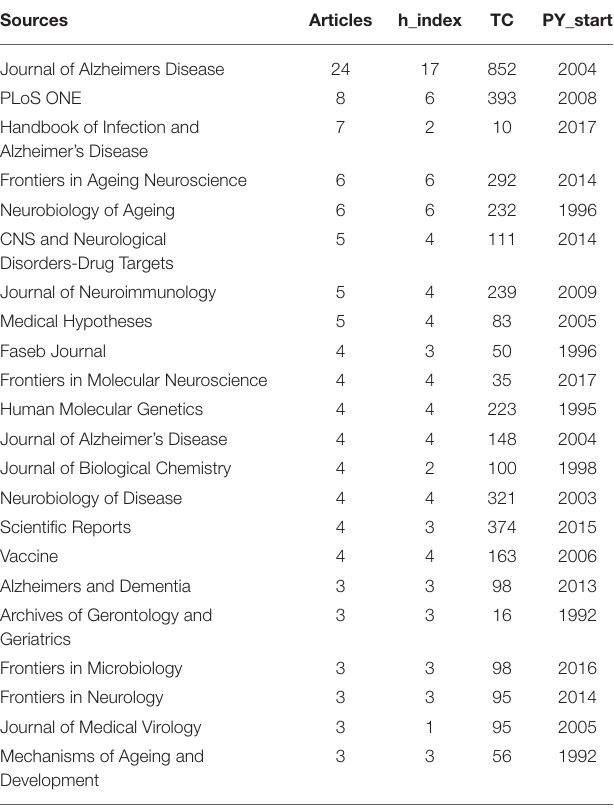
TABLE 6 | Most relevant sources on MPP-AD related research from 1982 to